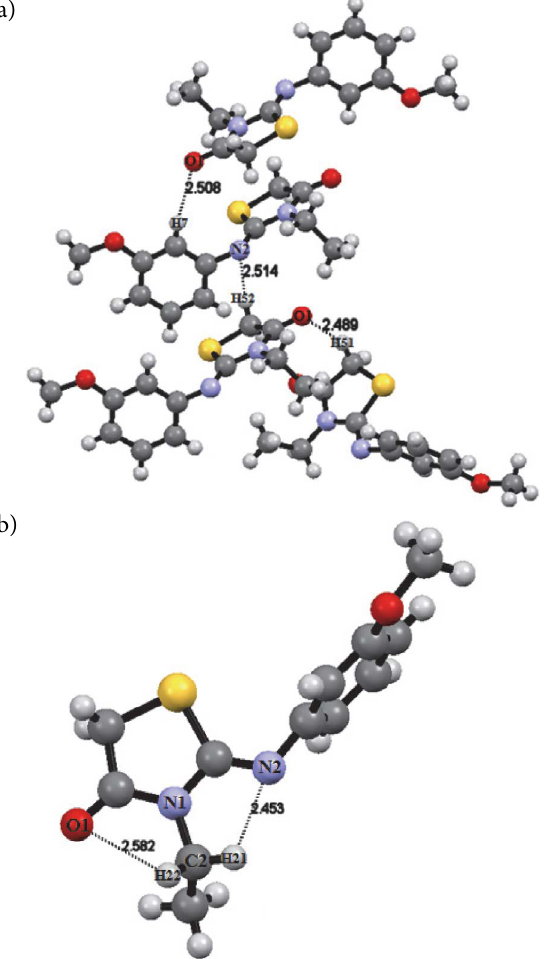
Figure 2 . Hydrogen bonding view in the crystal showing: (A) inter- molecular interactions, (B) C2–H21···N2 and C2–H22···O1 intra- molecular